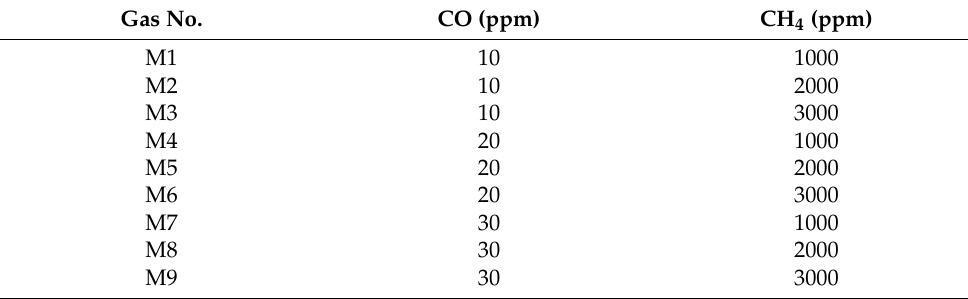
Table 2. The composition and concentration of experimental gas samples. Gas